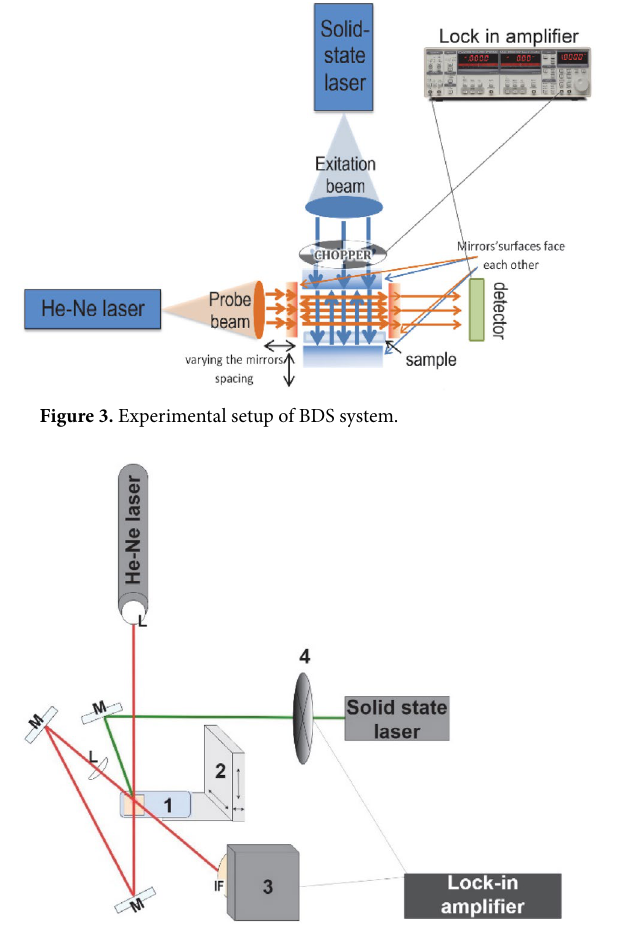
Figure 4. The scheme of BDS system with view from above, where: 1 – glass layer with a sample; 2 – 3D translation stage; 3 – detector; M – mirror; IF- interference filter; L –